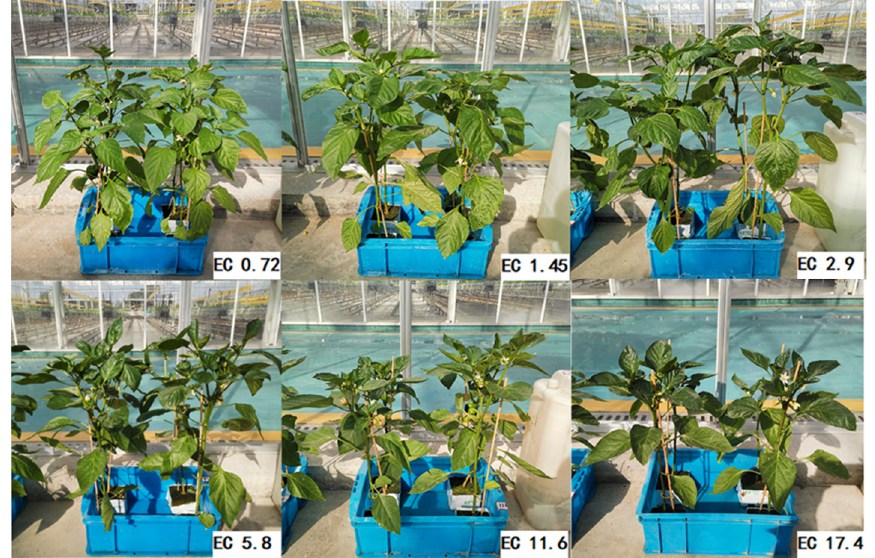
Figure 1. Pictures of plants in the pots of different EC treatments after 25 days of treatment. EC0.72, EC1.45, EC2.9, EC5.8, EC11.6, and EC17.4 represent the different nutrient solution electrical conduc- tivities of 0.72 dS m −1 , 1.45 dS m −1 , 2.9 dS m −1 , 5.8 dS m −1 , 11.6 dS m −1 , and 17.4 dS m −1 .